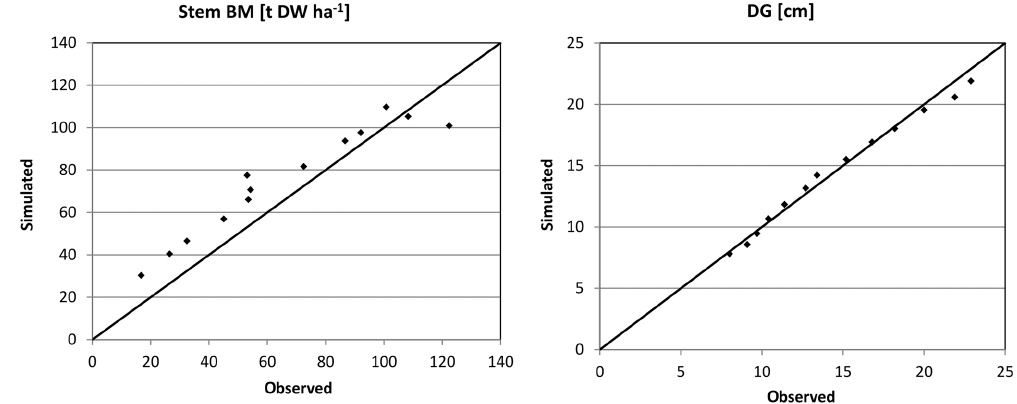
Figure 3. Simulated (sim) vs. observed (obs) DG and stem biomass (BM) for Peitz in the form of scatter plots with a 1 : 1 line.